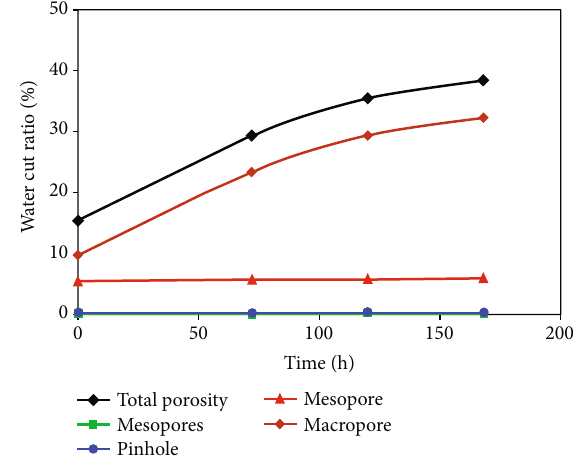
Figure 5: NMR T2 spectrum curve of core 1.